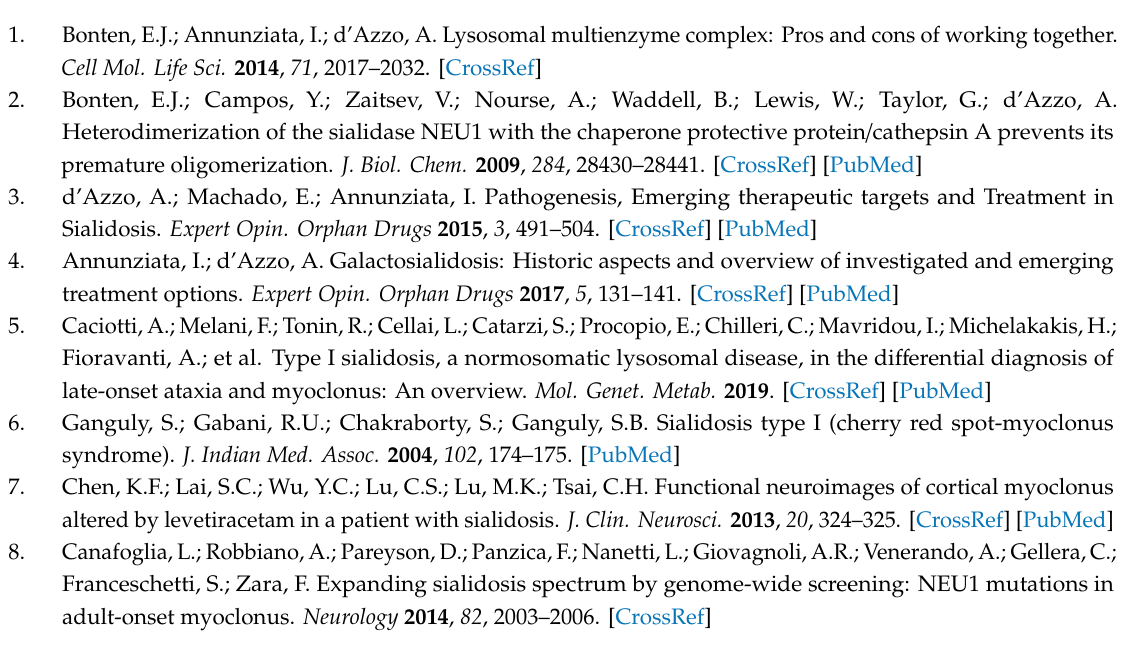
Figure S1: Quantification of endogenous NEU1 levels in the 12 type I sialidosis fibroblasts, normalized to the loading control ( n = 3). Graphs are presented as mean ± SD, **** p < 0.0001. Figure S2: Coomassie-stained membrane loaded with recombinant human PPCA (rhPPCA). Figure S3: Quantification of NEU1 levels in the 12 type I sialidosis fibroblasts after treatment with romidepsin calculated as fold of increase between treated versus untreated cells and normalized to loading control ( n = 3). Graphs are presented as mean ± SD, * p < 0.05, ** p < 0.01, *** p < 0.001, **** p < 0.0001. Figure S4: Quantification of NEU1 levels in the 12 type I sialidosis fibroblasts after treatment with betaine calculated as fold of increase between treated versus untreated cells and normalized to loading control ( n = 3). Graphs are presented as mean ± SD, * p < 0.05, ** p < 0.01, *** p < 0.001, **** p < 0.0001. Figure S5: Quantification of H3K4me3 levels in the 12 type I sialidosis fibroblasts after treatment with betaine calculated as fold of increase between treated versus untreated cells and normalized to loading control. Figure S6: Residual Neu1 activity in the Neu1 del654-659 (HO) model. (A) Electropherogram showing the 6 base pairs deletion. (B) Neu1 activity and (C) Quantification of Neu1 protein levels tested in kidneys of mice homozygous for the del654-659 mutation. Neu1 activity in (D) spleen and (E) liver of the same mouse model. Graphs are presented as mean ± SD, * p < 0.05, ** p <